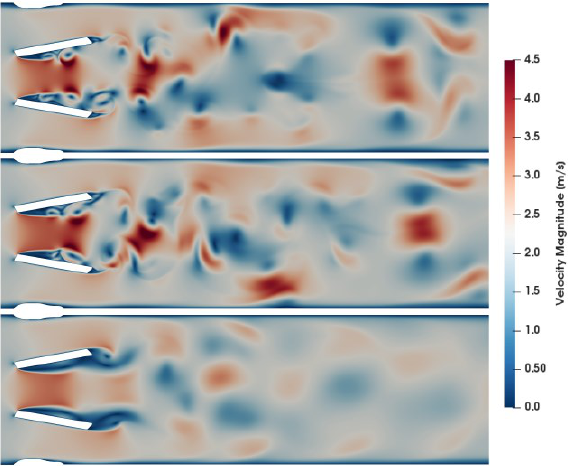
Fig. 3. Contours of velocity magnitude. DNS on fine grid (top, 1,25mil cells), DNS on coarse grid (middle, 520k cells), k-ω SST (bottom, 520k